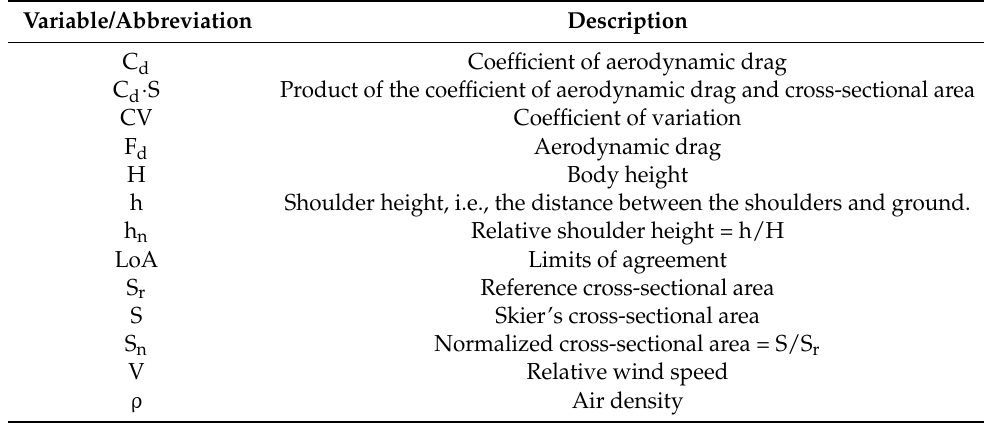
Table 1. The variables examined and their